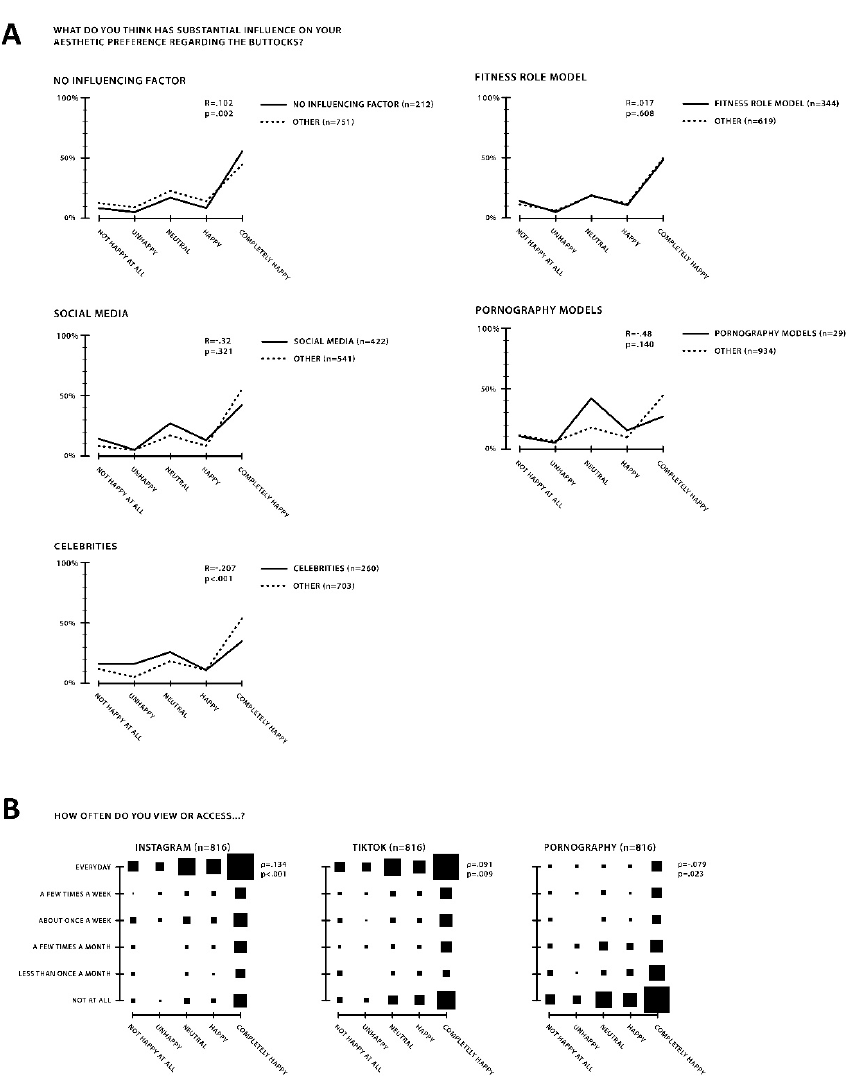
Figure 4. Influence of social media on happiness with one’s own buttocks in women. ( A ) Correlation of happiness with one’s own buttocks and the role models that influence the gluteal esthetics of the participants. Female participants were asked who their most influential role models were regarding gluteal esthetics. Multiple responses were possible: 212 (22%) participants stated no specific influencing factor, 422 (44%) social media, 260 (27%) celebrities, 344 (36%) fitness role models and 29 (<1%) pornography. A correlation was found between happiness and specific influencing factors with no specific role model (R = 0.102, p = 0 .002, ρ = 0.106) and celebrities (R = − 0.207, p < 0.001, ρ = − 0.218). Graphs show the percentage within each group and their distribution with respect to happiness. ( B ) Sizes of the matrix plot depict the distribution of happiness correlating with social media consumption. Participants were asked how often they accessed Instagram, TikTok and pornography. The frequency was correlated with the stated happiness with one’s own buttocks. Significant correlations were found between happiness and consumption frequency for all three media types: Instagram ( p < 0.001, ρ = 0.134), TikTok ( p = 0.009, ρ = 0.091) and pornography ( p = 0 .023, ρ = − 0.079). The p -value is stated as the level of significance calculated using the Pearson correlation factor (R) and Spearman rank correlation ( ρ ). n = 963 female